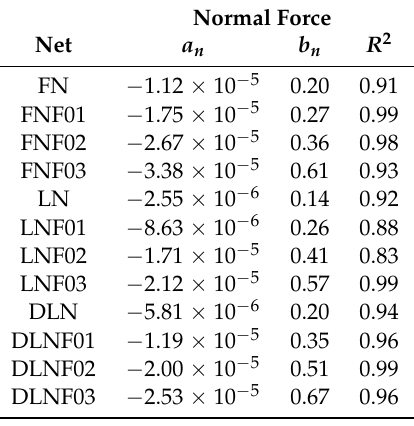
Table 4. Coefficients a and b for C Dn = a n ( S n ) Re + b n ( S n ) fitting for normal drag coefficient